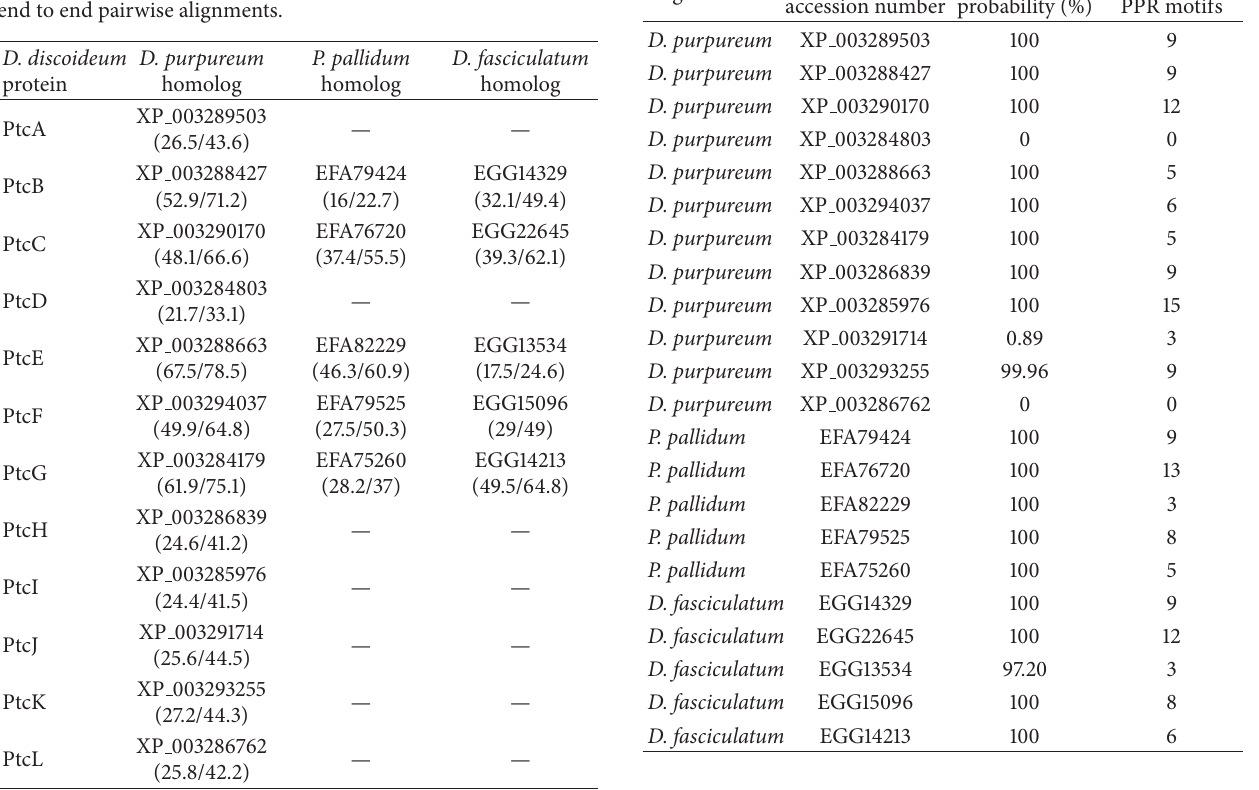
Table 4: Bioinformatic analysis of unique PPR proteins found in one, but not in other cellular slime moulds. The probability of helical repeats being PPR and the predicted number of motifs were determined using